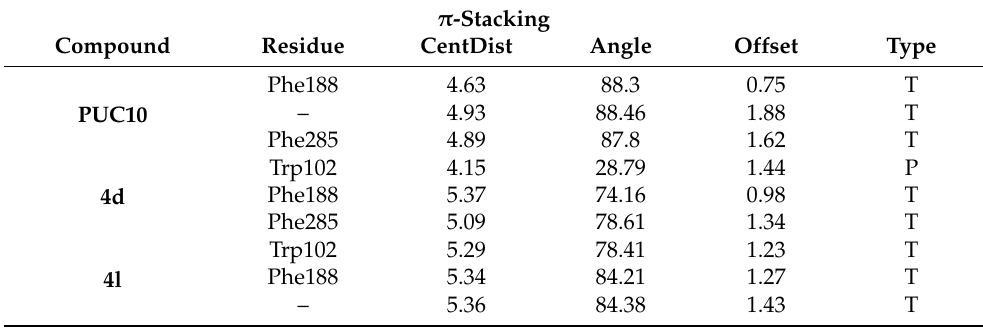
Table 3. π -stacking interactions established with residues within the binding site and compounds PUC10 , 4d and 4l